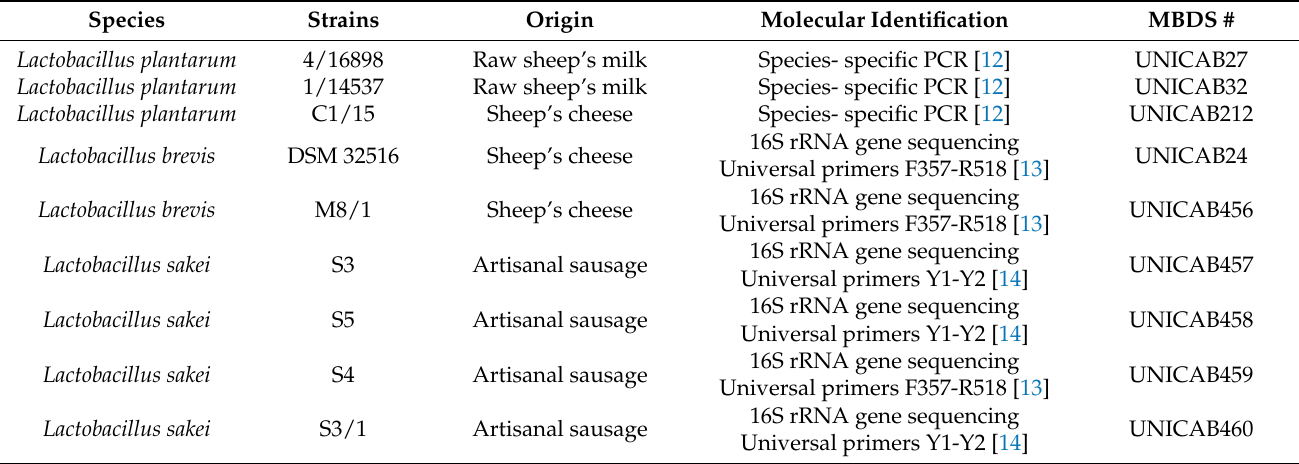
Table 1. List of the Lactobacillus strains and food